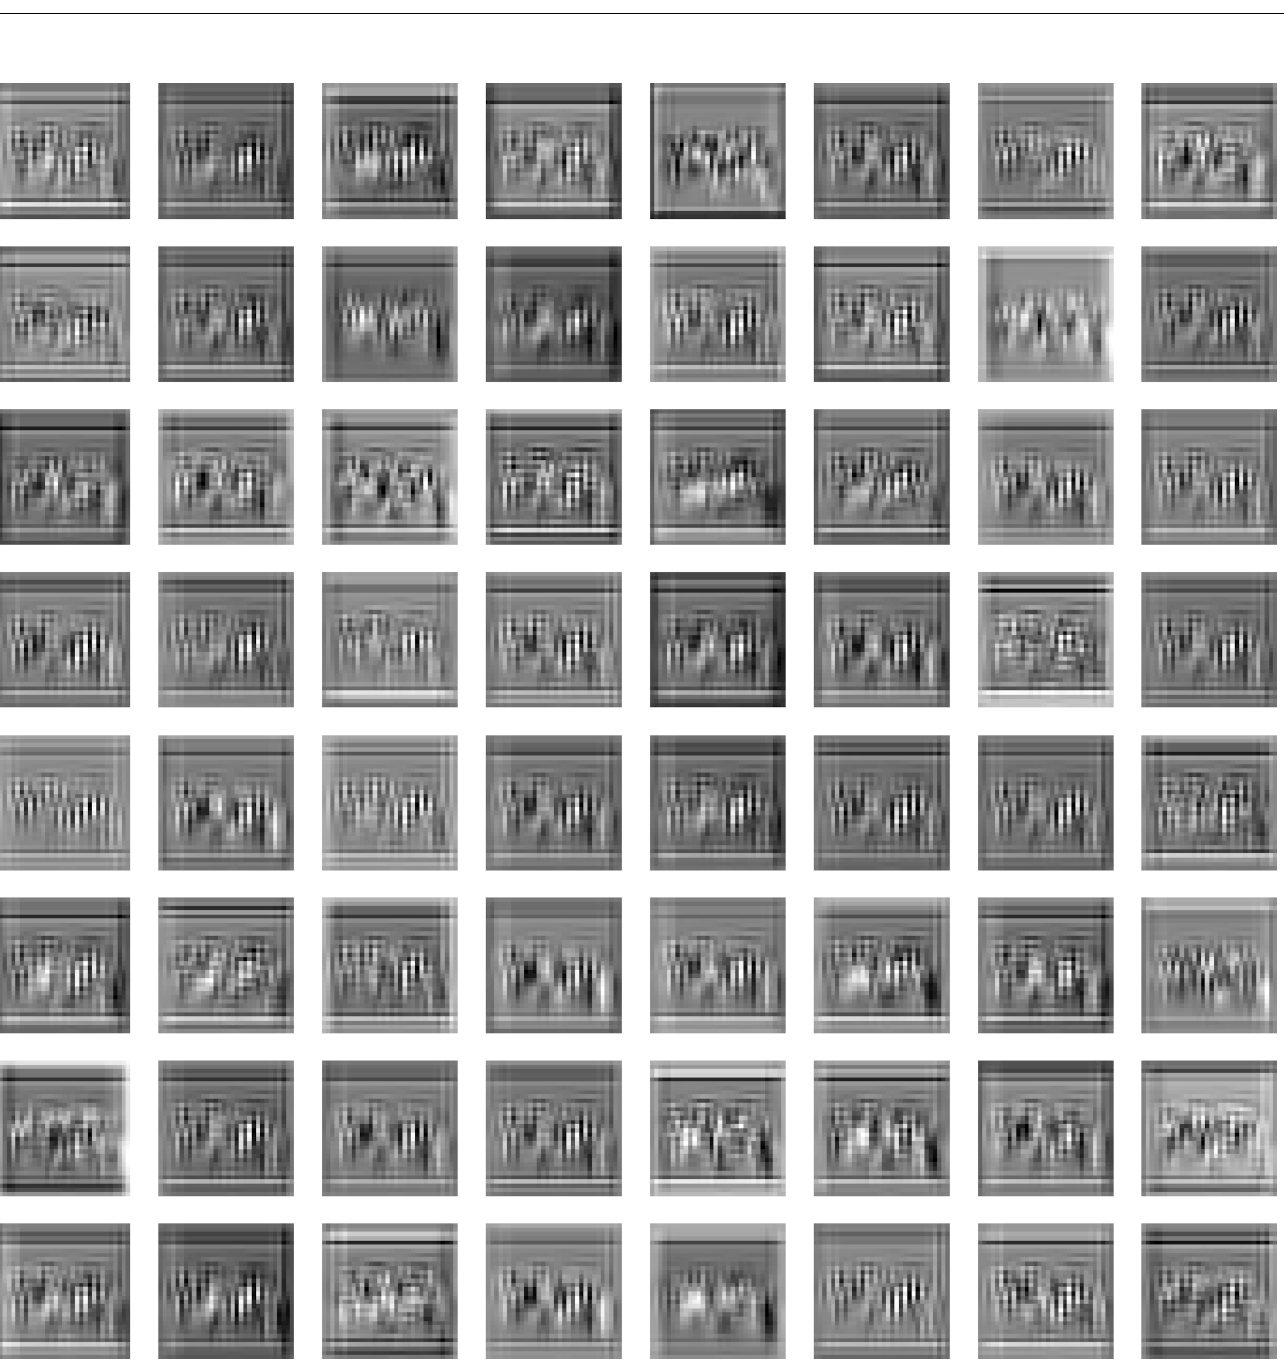
Figure 17. Feature Map Extraction Convolutional Layer 48.